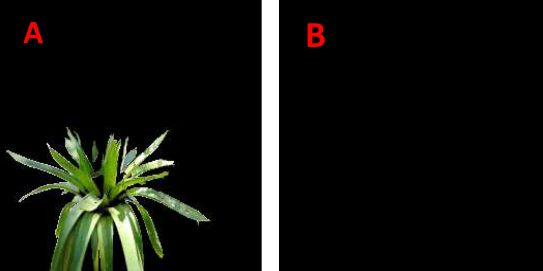
Figure 3. The high SSIM score of an input image (A) with minimal target occupancy and incorrectly predicted label (B) due to high overlap between black regions.